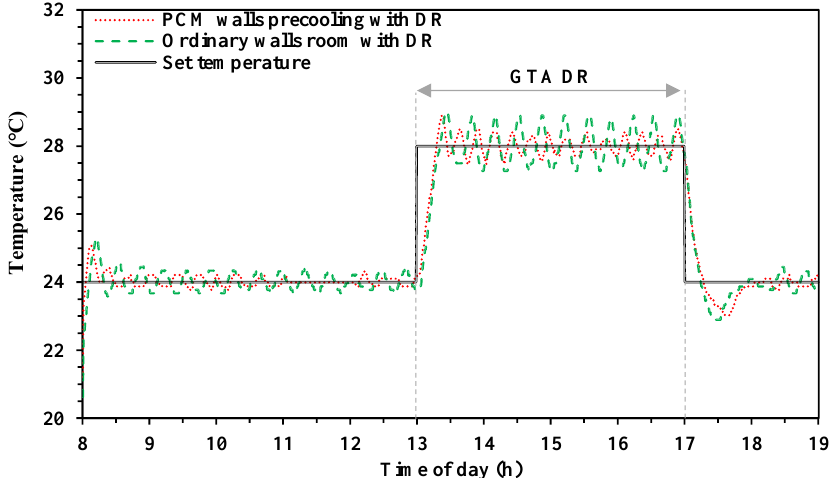
Figure 8. Real-time temperature of experimental rooms.